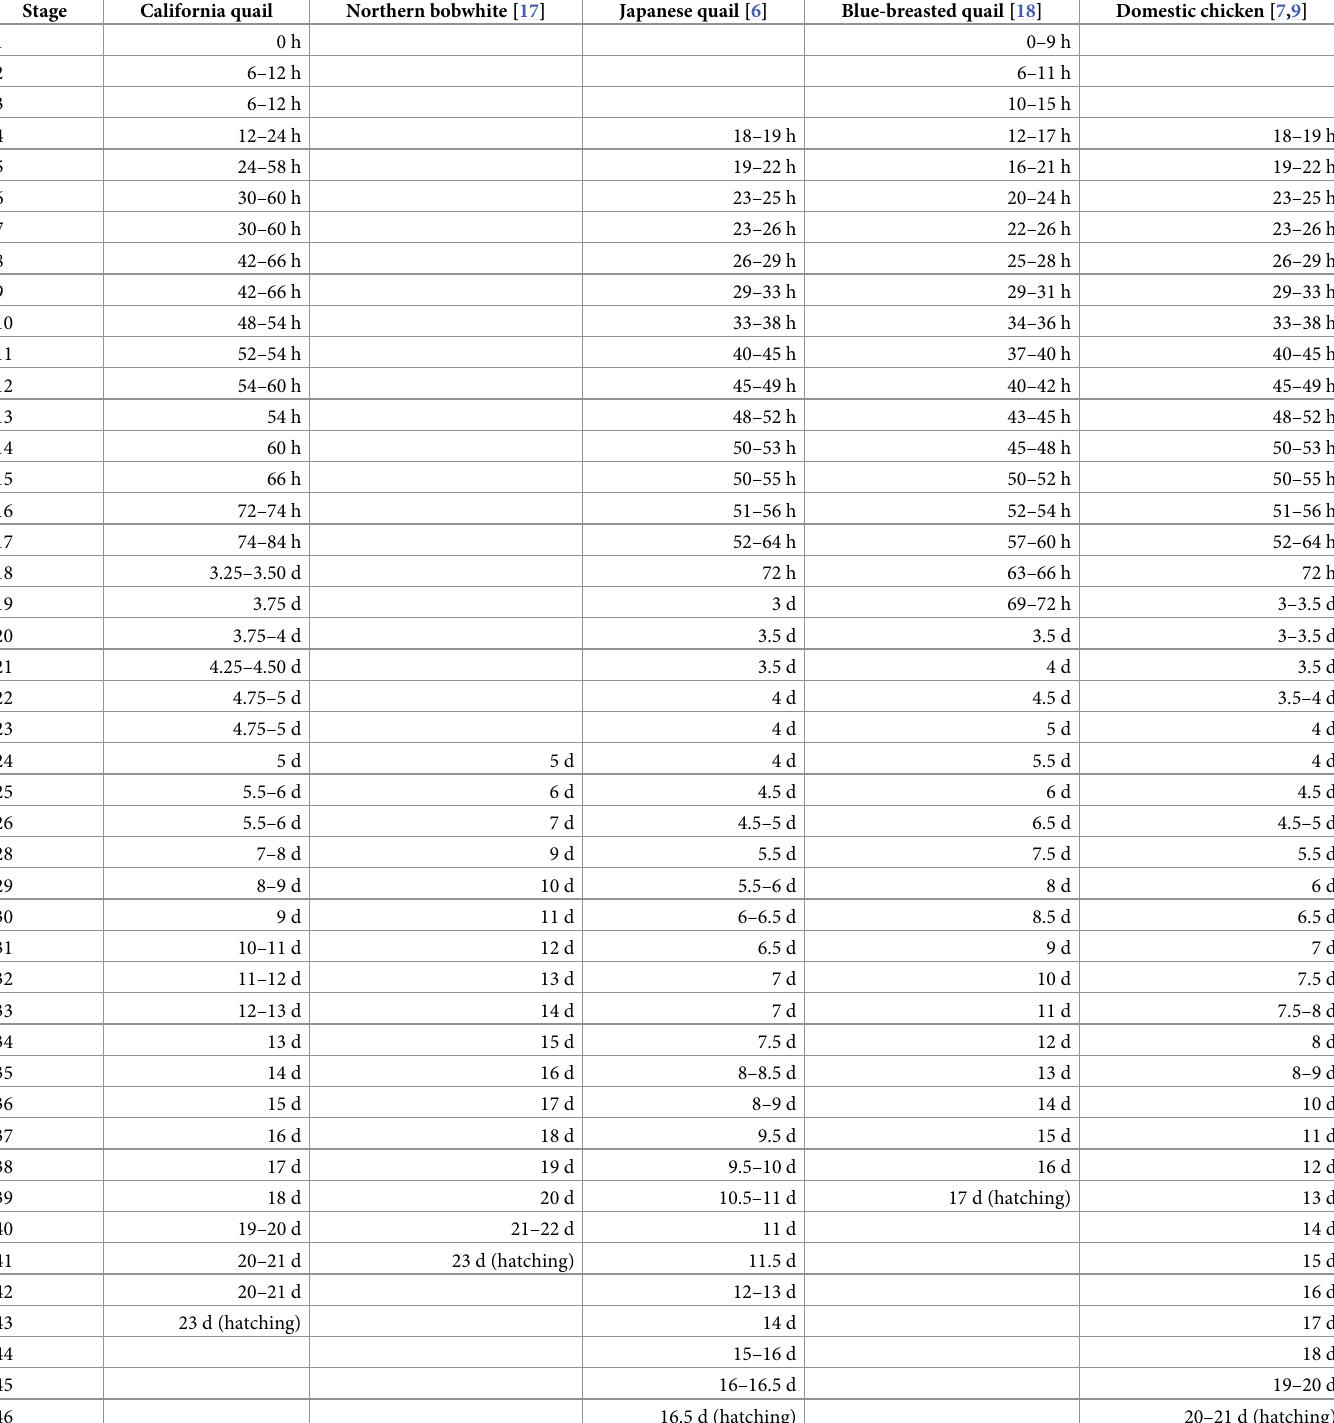
Table 1. Comparison of developmental stages of California quail ( Callipepla californica ), northern bobwhite quail ( Colinus virginianus ), Japanese quail ( Coturnix japonica ), blue-breasted quail ( Synoicus chinensis ), and domestic chicken ( Gallus gallus domesticus